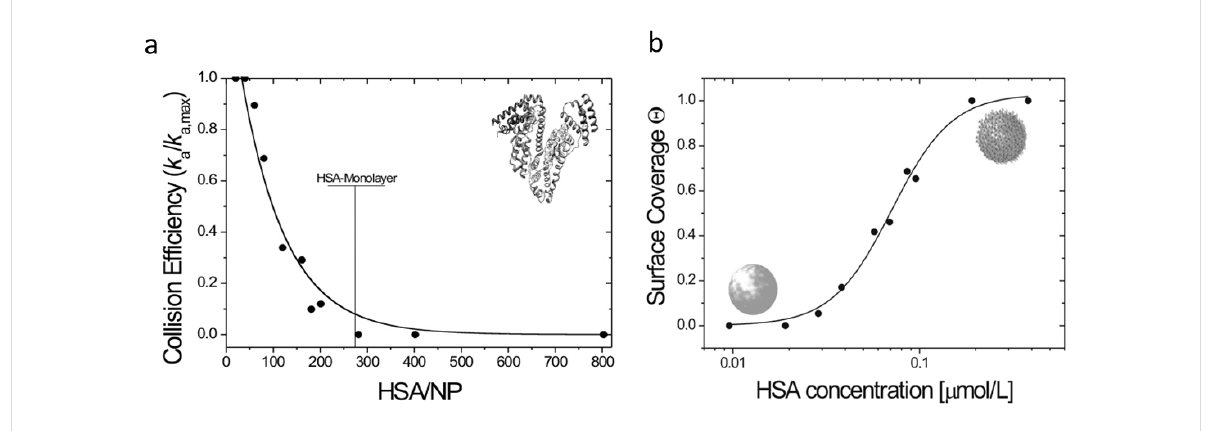
Figure 1: (a): Relation between the collision efficiency regarding the formation of agglomerates in a destabilized colloidal and the relative HSA concentration in solution [53]. Black dots: data points, black solid line drawn to guide the eye. The collision efficiency becomes zero around the point where monolayer surface coverage can be expected. (b): Data-plot of surface coverage versus the logarithmic HSA-concentration from the same study [53]. Surface coverage was inferred from the stabilizing effect of the HSA corona forming around the deliberately destabilized colloid. Black dots: data points, black solid line: Hill fit to the data points ( K D = 71 ± 17 nmol·L − 1 , n = 2.71) indicating a cooperative binding behavior. Reproduced with permission from [53]. Copyright 2012 American Chemical Society.